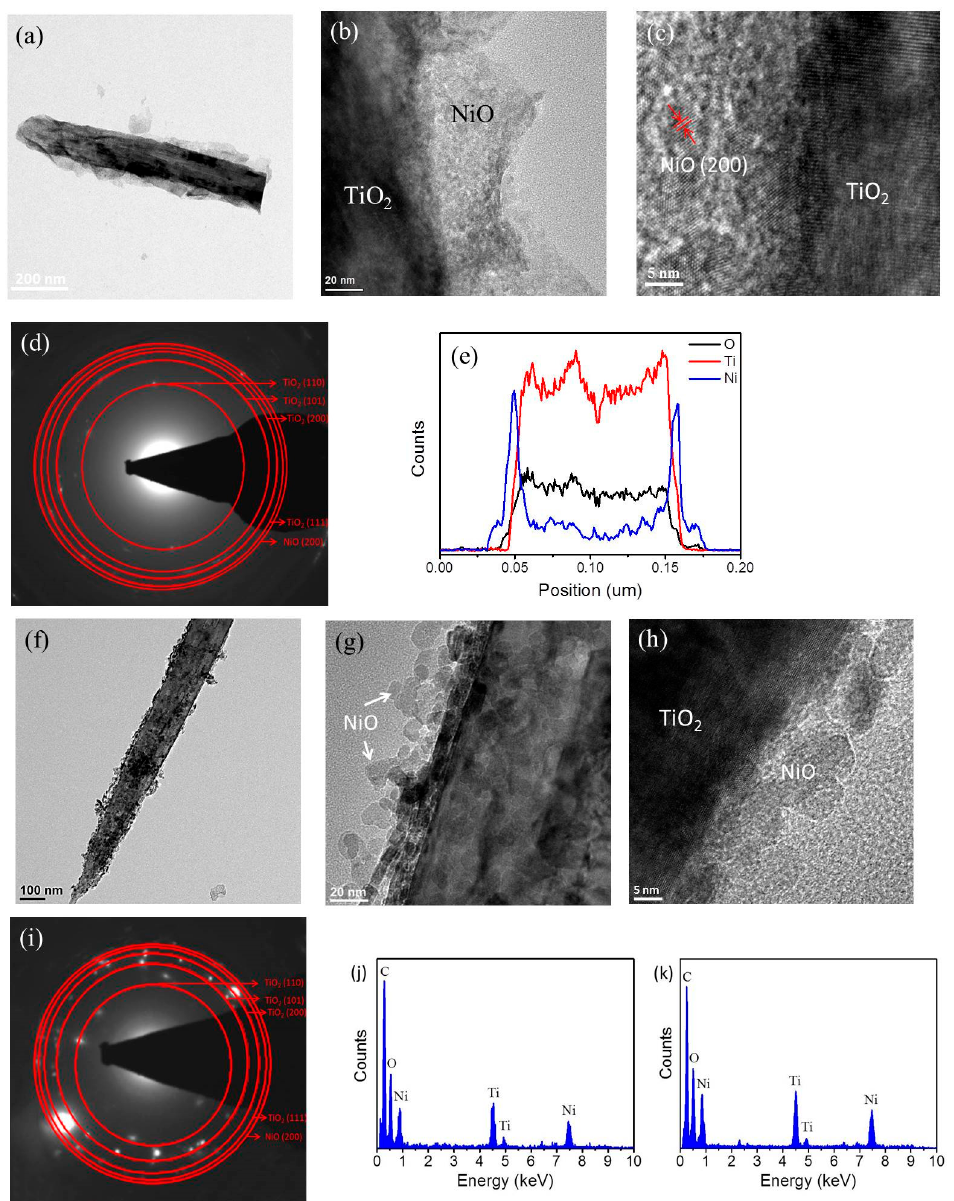
Figure 3. TEM analyses of TiO 2 –NiO composites formed at 350 °C : ( a ) Low-magnification TEM image of a single TiO 2 –NiO composite. ( b ) High-magnification TEM image taken from the TiO 2 –NiO composite. ( c ) High-resolution transmission electron microscopy (HRTEM) image taken from the local region of the TiO 2 –NiO composite. ( d ) Selected area electron diffraction (SAED) pattern of several TiO 2 –NiO composites. ( e ) Energy dispersive X-ray spectroscopy (EDS) line-scanning profiles of the TiO 2 –NiO composite. TEM analyses of TiO 2 –NiO composites formed at 500 °C. ( f , g ) Low- and high-magnification TEM images of a single TiO 2 –NiO composite, respectively. ( h ) HRTEM image taken from the local region of the TiO 2 –NiO composite. ( i ) SAED pattern of several TiO 2 –NiO composites. ( j , k ) EDS spectra of the NiO-nanoparticle-decorated TiO 2 nanostructures (NPT) and NiO-nanosheet-decorated TiO 2 nanostructures (NST) composites, respectively.